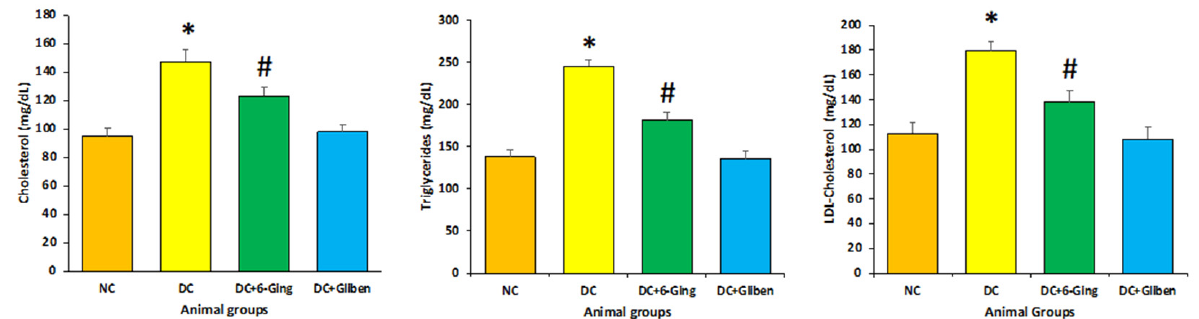
Figure 2. The lipid profile in different groups of rats after 8 weeks of continues treatment. The rats were equally divided into 4 groups, each group ( n = 8). Data are presented as mean ± standard error of the mean (SEM). Groups: Normal control (NC); disease control (DC), i.e., STZ-treated group; treatment group (DC + 6-gingerol); positive control (PC) animal treated with STZ + glibenclamide; * p < 0.05 (significant difference of final b.w. between DC vs. NC) # p < 0.05 (significant difference of final b.w. between DC vs. DC + 6-gingerol).